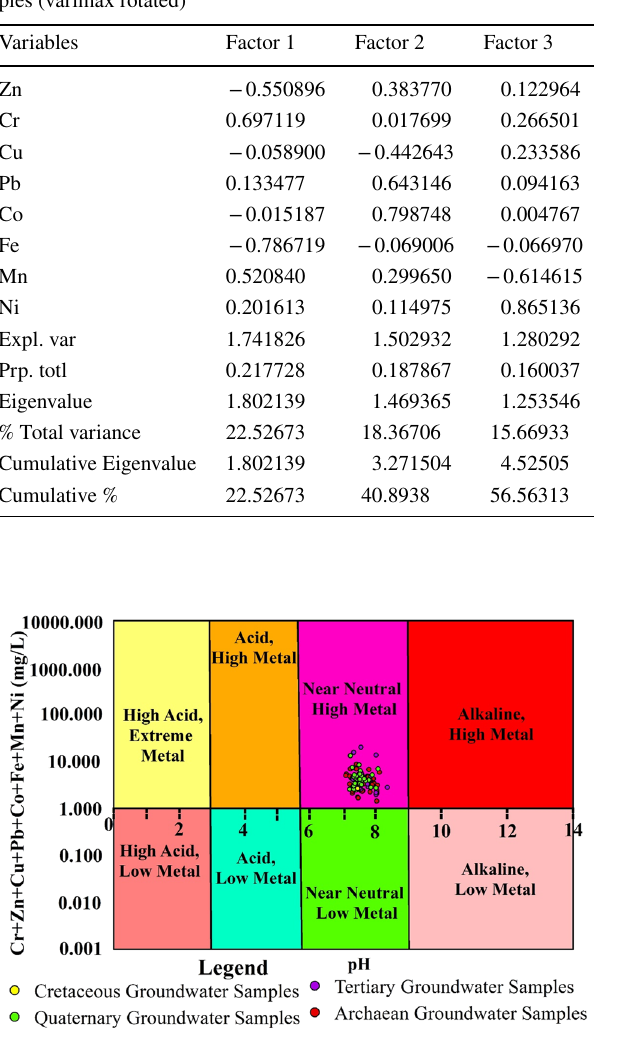
Fig. 14 Taxonomy effect plot with respect to heavy metals vs